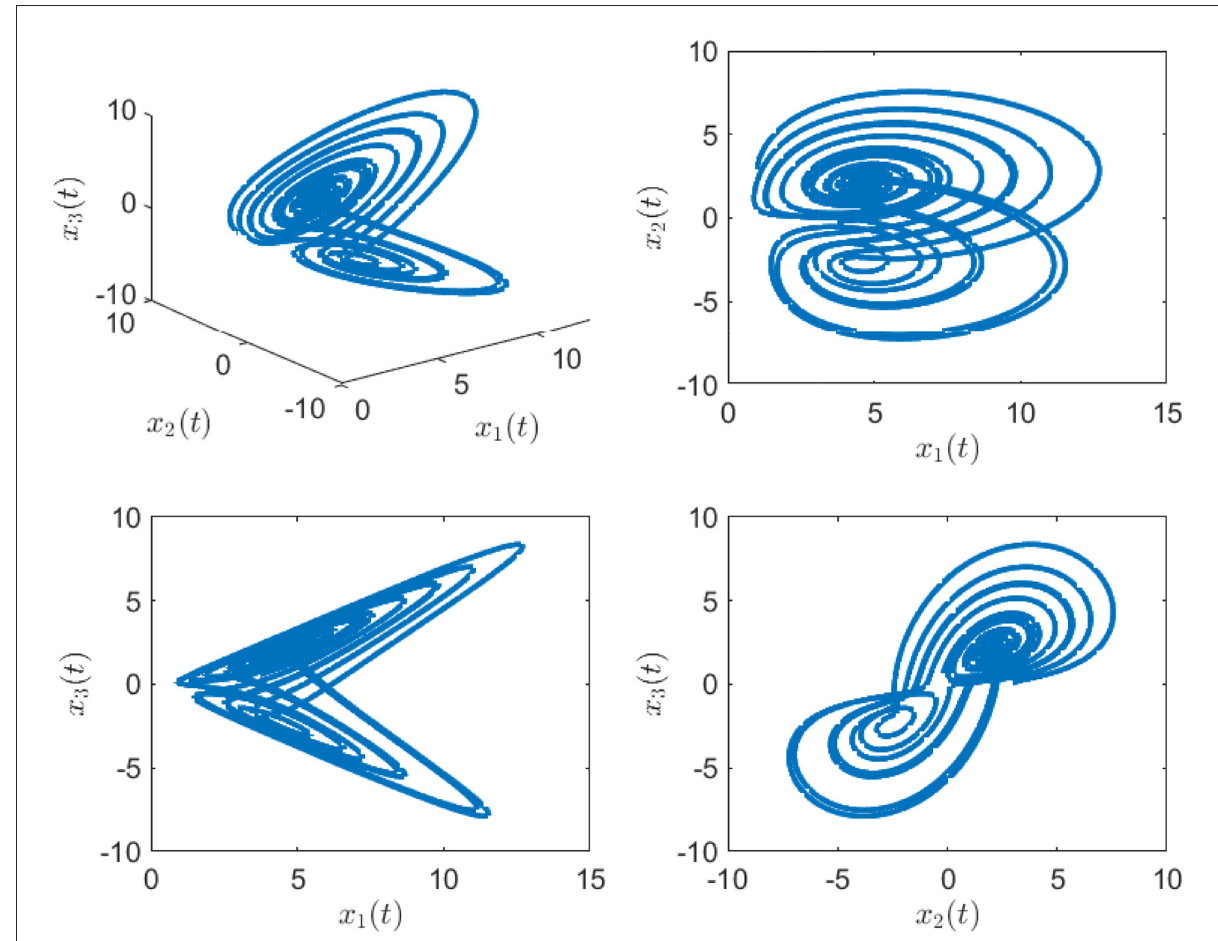
FIGURE1 The chaotic phenomenon of the master